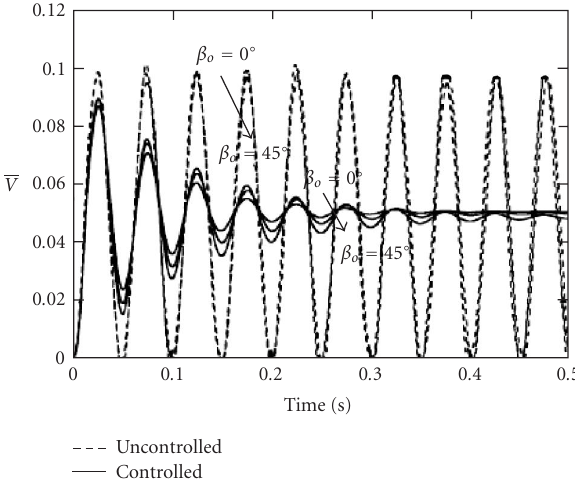
Figure 20: Influence of the pretwisted angle on the uncontrolled/ controlled flapping nondimensional deflection time-history of ro- tating blade subjected to the step loading with σ = 1, γ = 0deg, Ω = 100 rad/s, and θ = 45